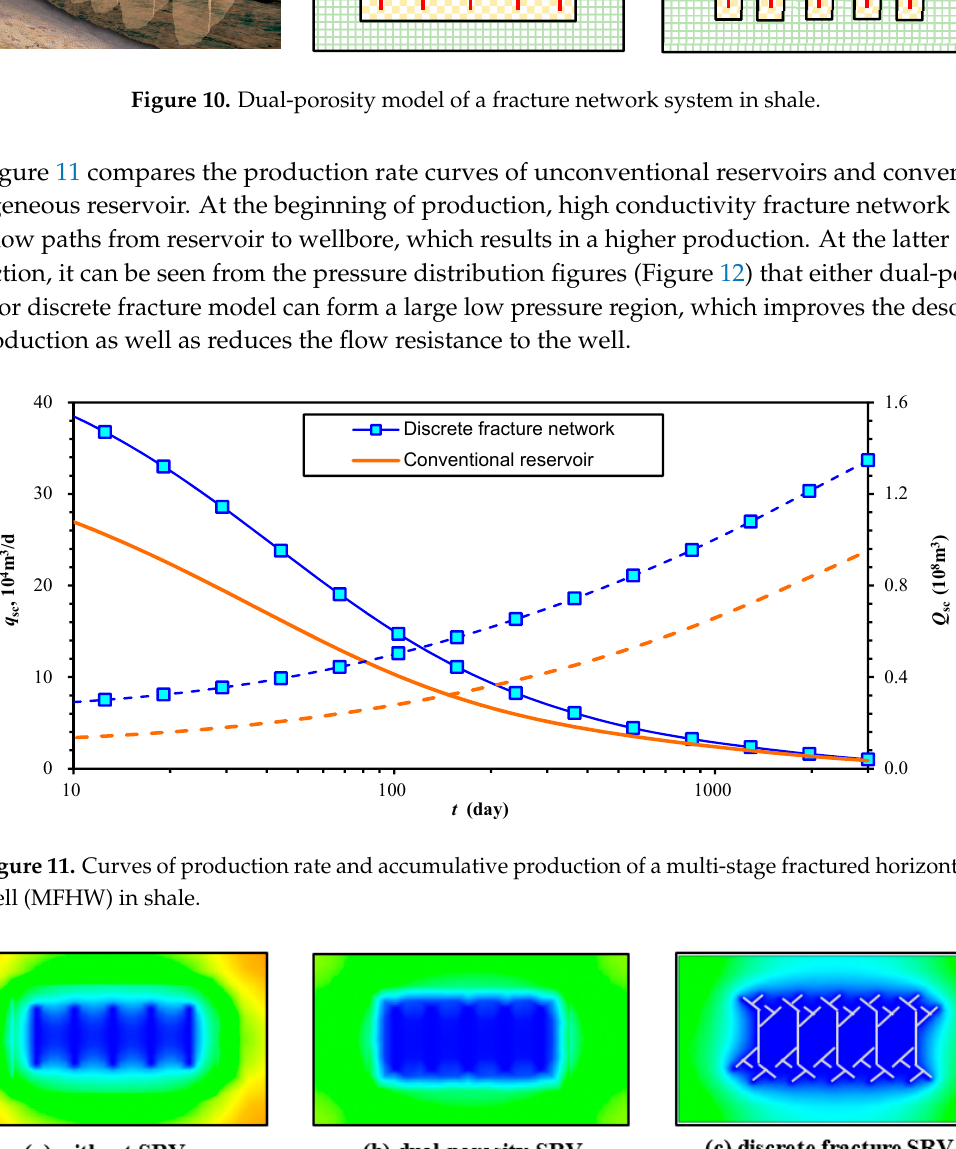
Figure 10. Dual-porosity model of a fracture network system in shale.